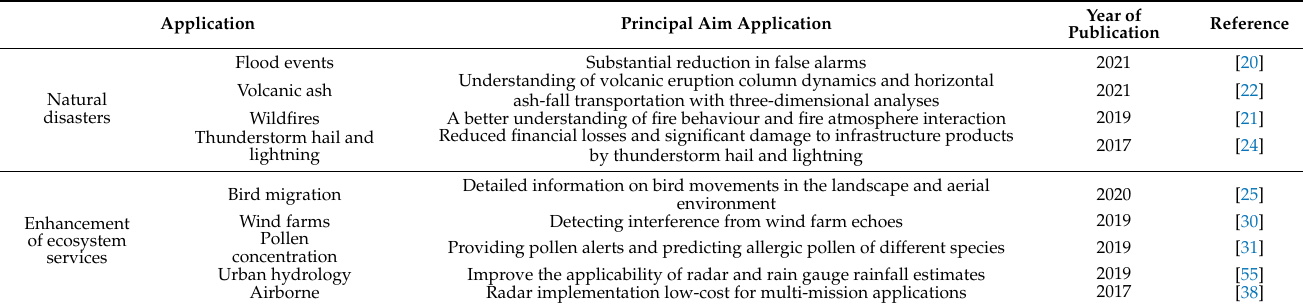
Table 1. Recent advanced worldwide